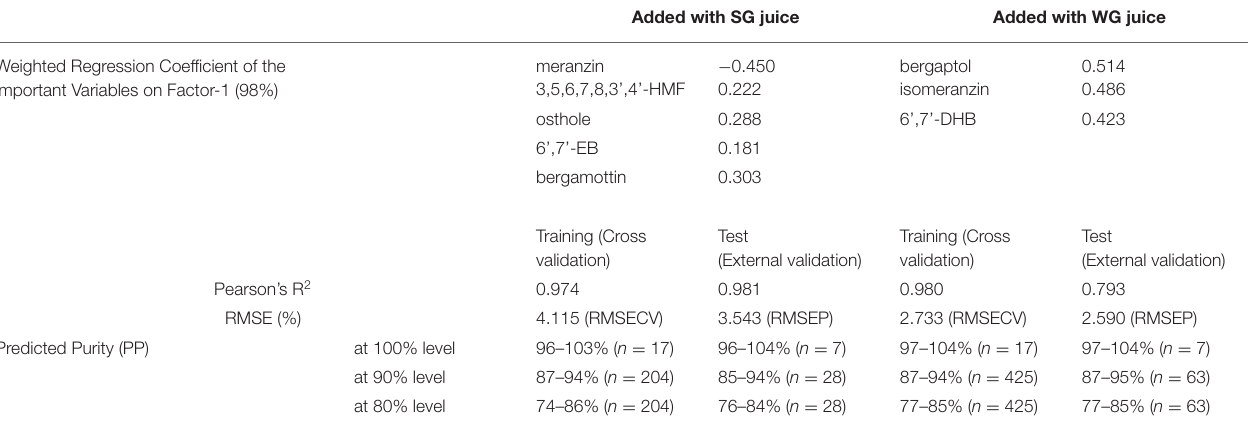
Added with SG juice Added with WG juice